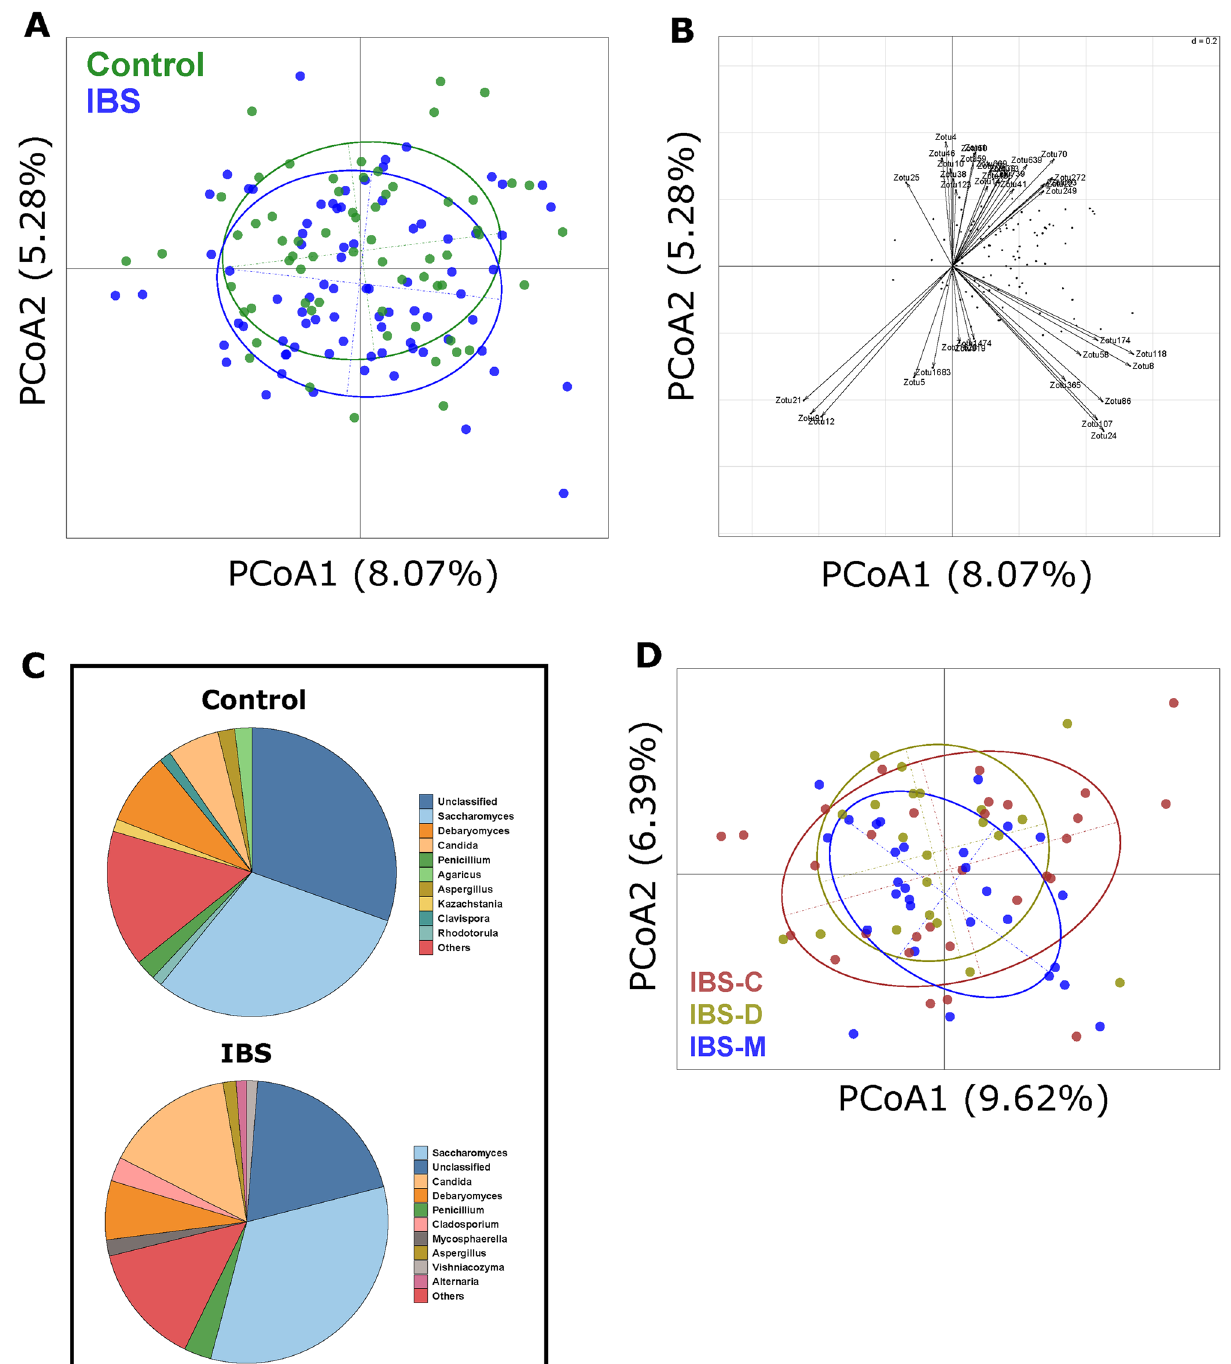
Figure 1. Mycobiome compositional differences between IBS and Control subjects. ( A ) Principal coordinate analysis of sample data (n = 144) using Bray–Curtis distance using log10 transformed abundance of zOTUs. A significant separation was observed between IBS (n = 80), and control (n = 64) samples, along the second principal axis. Significance was determined using permutational multivariate analysis of variance based on Bray–Curtis distance (Adonis; p-value = 0.004). ( B ) Features and their correlation with second principal axis, showing direction of association. Features showing significant spearman correlation (adj p < 0.05) between their abundance and second axis are shown with labelled arrows. ( C ) Pie charts showing top 10 abundant fungal genera in Control (n = 64) and IBS populations (n = 80). ( D ) Principal coordinate analysis based on Bray Curtis distance and log10 transformed zOTU abundance profile of clinical sub-types of IBS population. No significant differences were observed between the 3 clinical subtypes (IBS-C: n = 30, IBS-D: n = 21 and IBS-M: n = 29), (Adonis; p-value =